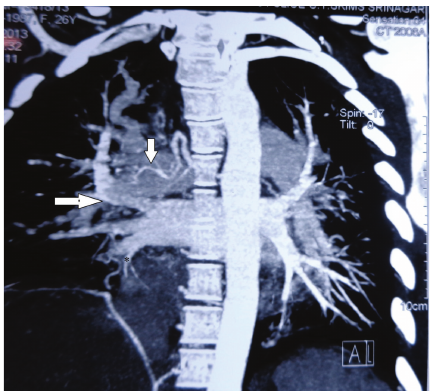
Figure 4: CT pulmonary angiography showing filling defects suggestive of thrombi in the pulmonary vessels (horizontal arrow). Pruning of pulmonary vessels is seen (asterisk). Also collateral vessels have started forming (vertical